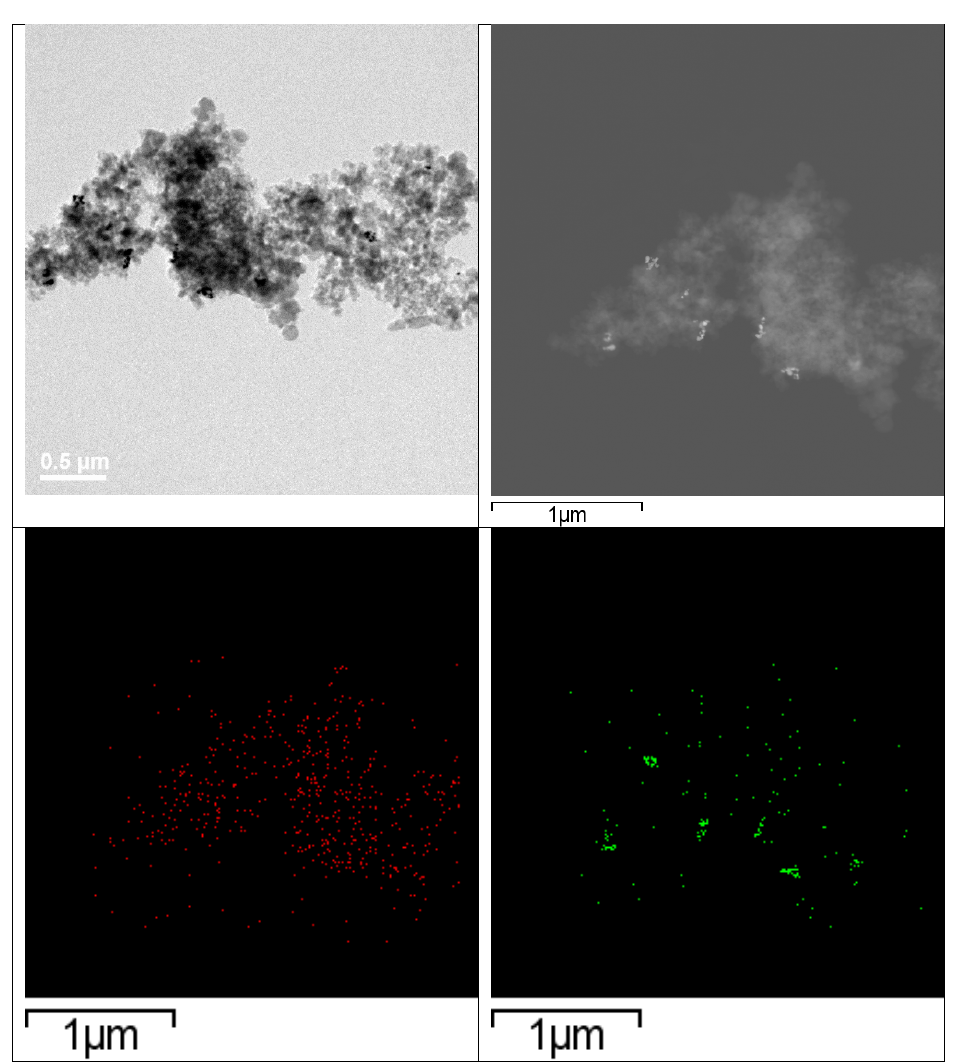
Figure 5. Energy-dispersive X-ray spectroscopy (EDS) analysis of GNP solutions was obtained with an HNO 3 addition of 30 μ L within a growth solution (Sample A). In addition, red and green square represent the distribution of nitrogen and gold, respectively.